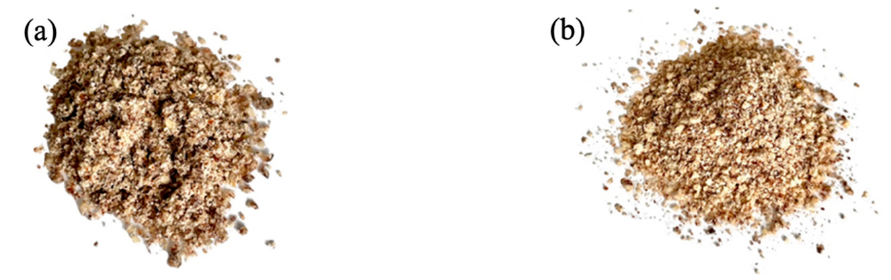
Figure 1. Optical image of ( a ) unmodified plum filler; ( b ) silanized plum filler.